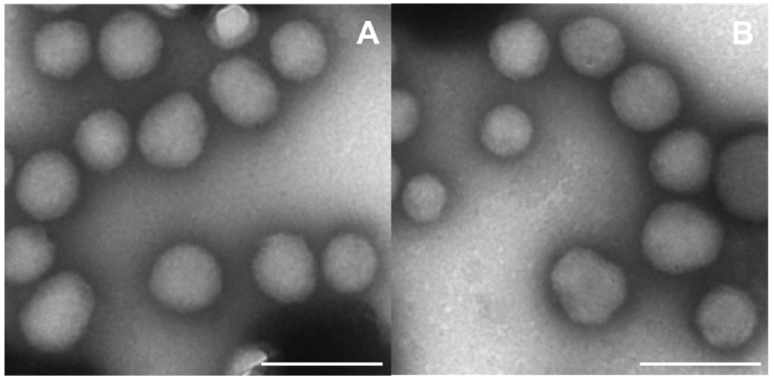
Figure 1. TEM analysis of ( A ) empty zein nanoparticles (2 mg/mL of protein stabilized with sodium deoxycholate) and ( B ) nanosystems prepared with 0.3 mg/mL of JQ1 and PTX. Magnification: deoxycholate, ( B ) nanosystems prepared with 0.3 mg/mL of JQ1 and PTX. Magnification: 30,000 × , 30,000×, Bar = 200 nm. Bar = 200